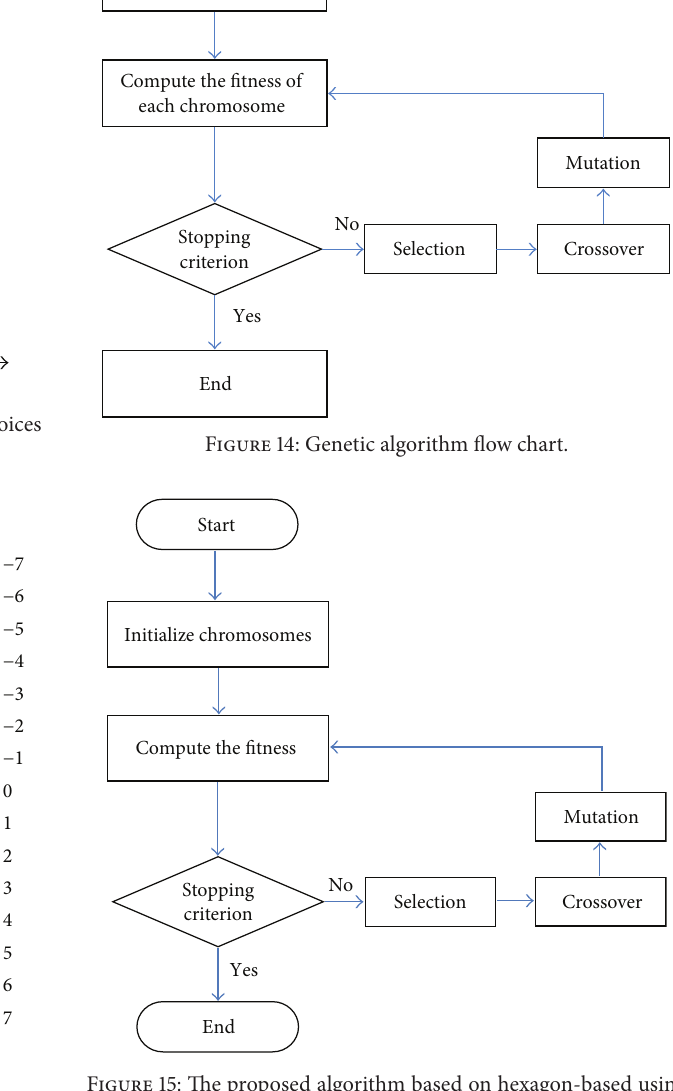
Figure 13: When getting the worse choice, the longer path would be processed.